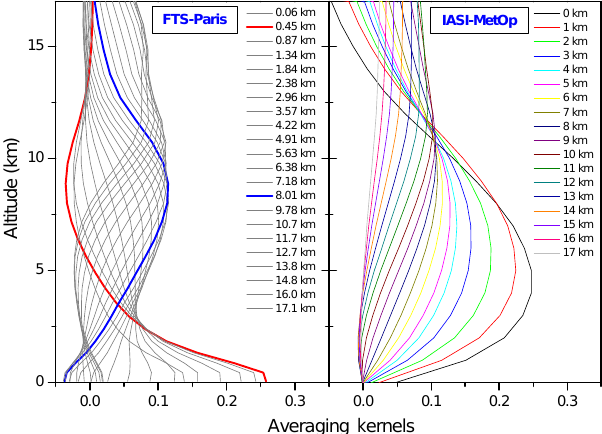
Figure 5. CO averaging kernels for each altitude of the a priori pro- file (from 0 to 17km) for FTS-Paris (left panel) and IASI–MetOp (right